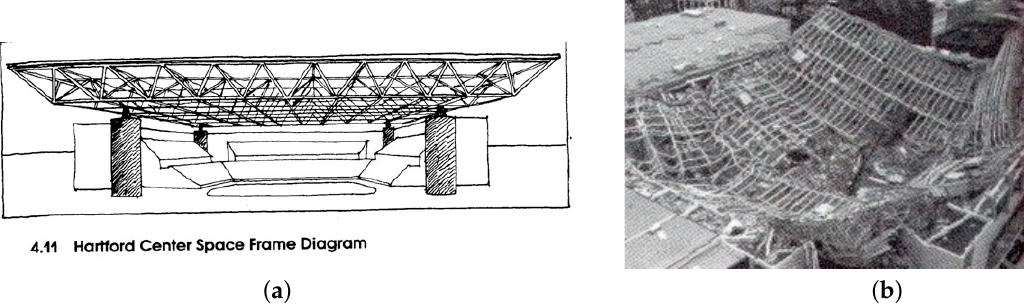
Figure 25. The design of the Hartford roof as a half-octahedral tetrahedral truss ( a ) and an image after the collapse from a snow load ( b ), shortly after the sports fans left the arena